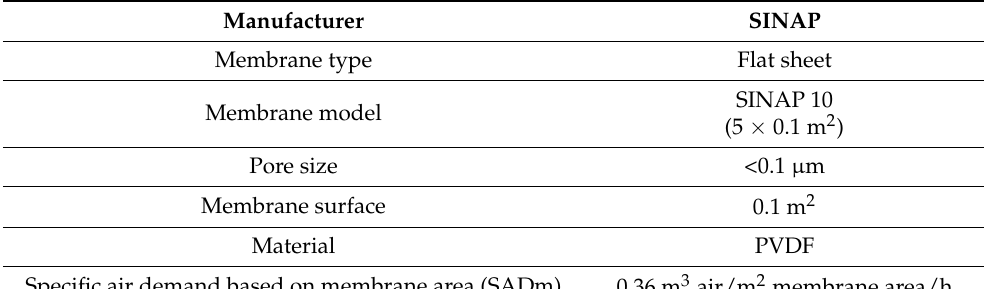
Table 3. AnMBR membrane characteristics.